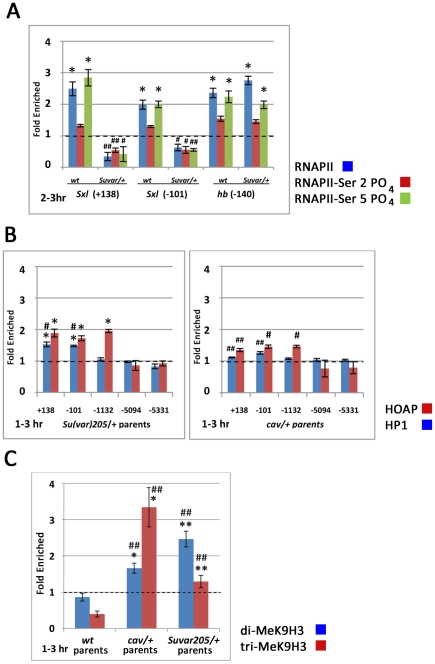
Chromatin immunoprecipitation (ChIP) assays show perturbations in Sxl
Pe chromatin in embryos from HOAP and HP1 mutant mothers.(A) Bar graphs show SxlPe (Sxl +138 and −101) and hunchback (hb −140) promoter sequences in RNA polymerase II ChIP fractions from embryos produced by either wild type (wt) or Su(var)205
5/+ mothers crossed to Sxl
f1/Y fathers. ChIP assays for unphosphorylated (blue bar), Ser2-phosphorylated (red bar), or Ser5-phosphorylated (green bar) RNA polymerase II are shown. (p(no enrichment)<0.05*; change between wild type and mutant embryos, p(no change)<0.05#, <0.01##) (B) Bar graphs show changes in the enrichment of Sxl sequences in HOAP- (red bars) and HP1- (blue bars) ChIP fractions in embryos produced by Su(var)205
5/CyO parents (left) and by cav
2248/TM3, Sb parents (right). (p(no enrichment)<0.05*; change between wild type and mutant embryos, p(no change)<0.05#, <0.01##) (C) Bar graphs show changes in the enrichment of Sxl sequences in di-MeK9H3- (blue bars) and tri-MeK9H3- (red bars) ChIP fractions in embryos produced by wt, Su(var)205
5/CyO and cav
2248/TM3, Sb parents. (p(no enrichment)<0.05*; change between wild type and mutant embryos, p(no change)<0.05#, <0.01##).